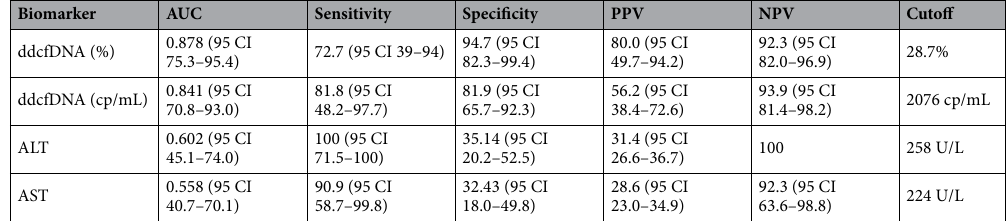
Table 3. Diagnostic performance from ROC (%) in rejection vs. no rejection group. AUC area under the curve, dd-cfDNA donor-derived cell-free DNA, ALT alanine aminotransferase, AST aspartate aminotransferase, 95% CI 95% confidence interval, PPV positive predictive value, NPV negative predictive